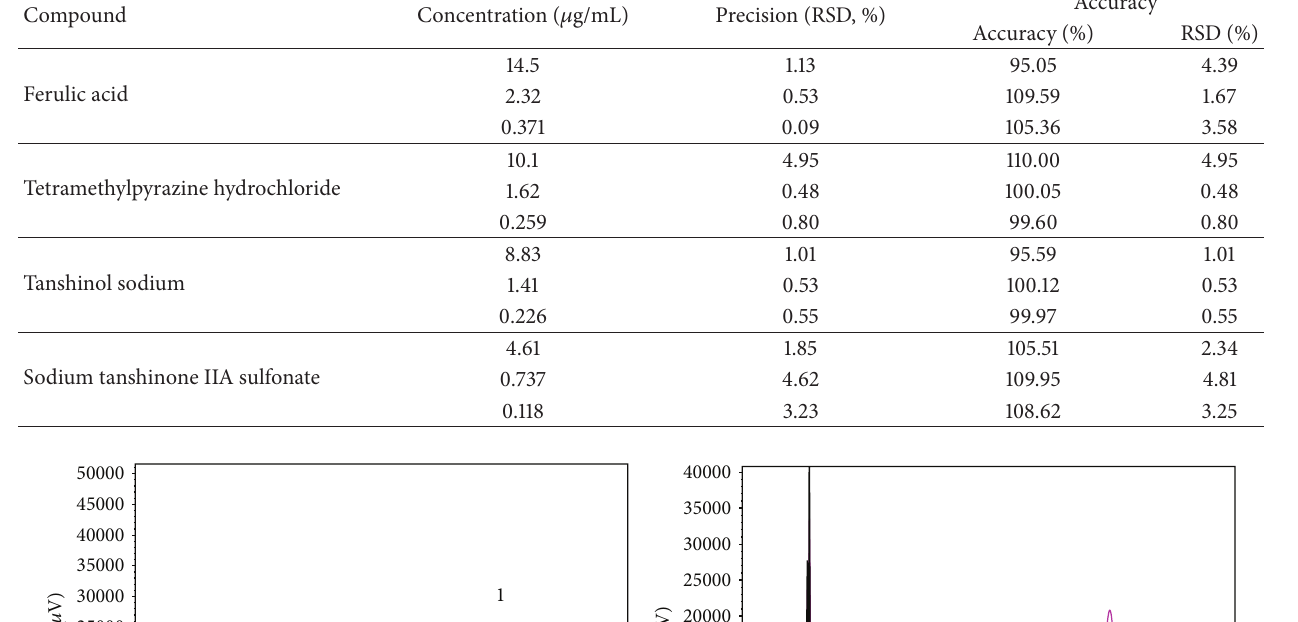
Table 5: The precision and accuracy of 4 compounds in rat plasma (𝑛 = 5) .